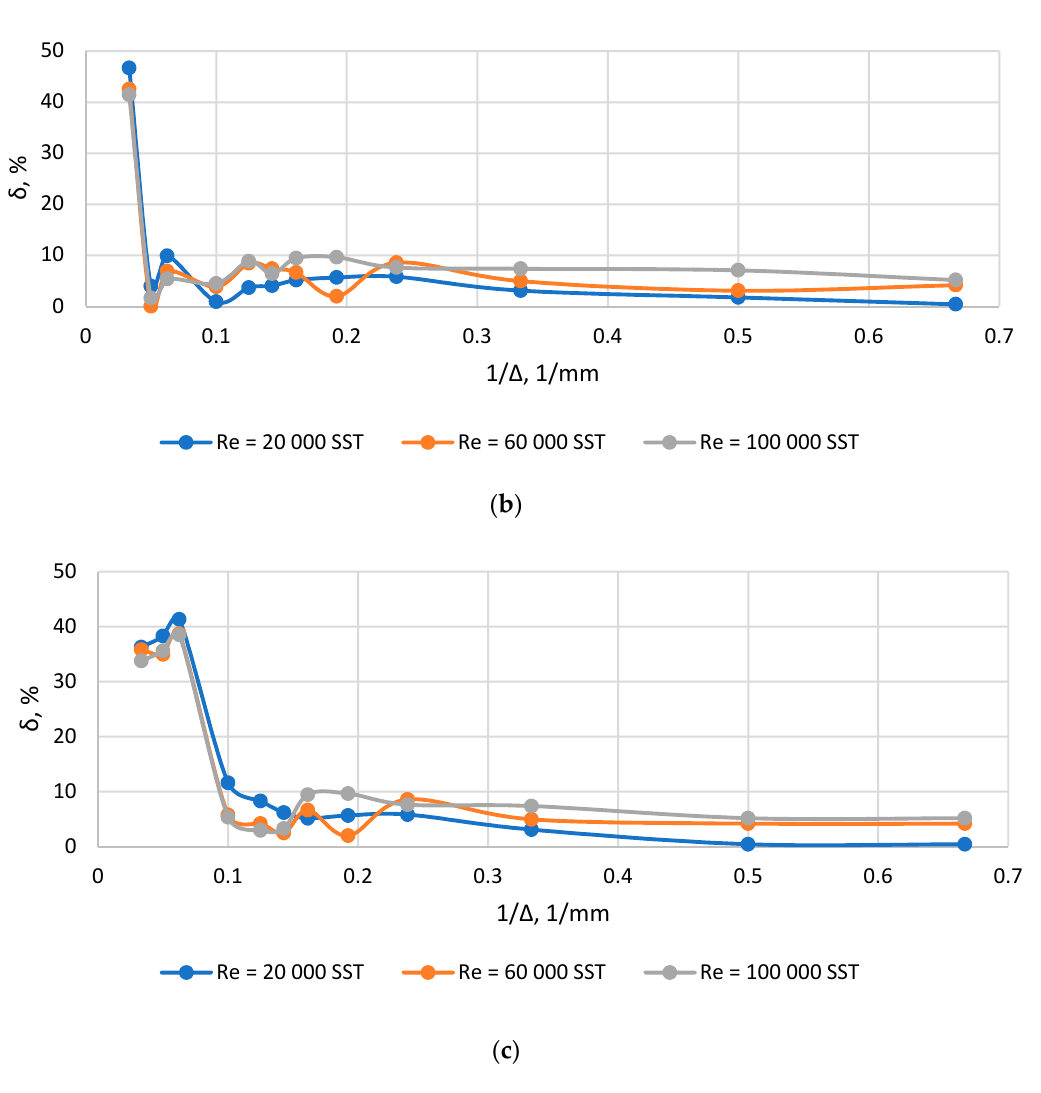
0 / F 1 = 0.1; ( b ) F 0 / F 1 = 0.3;